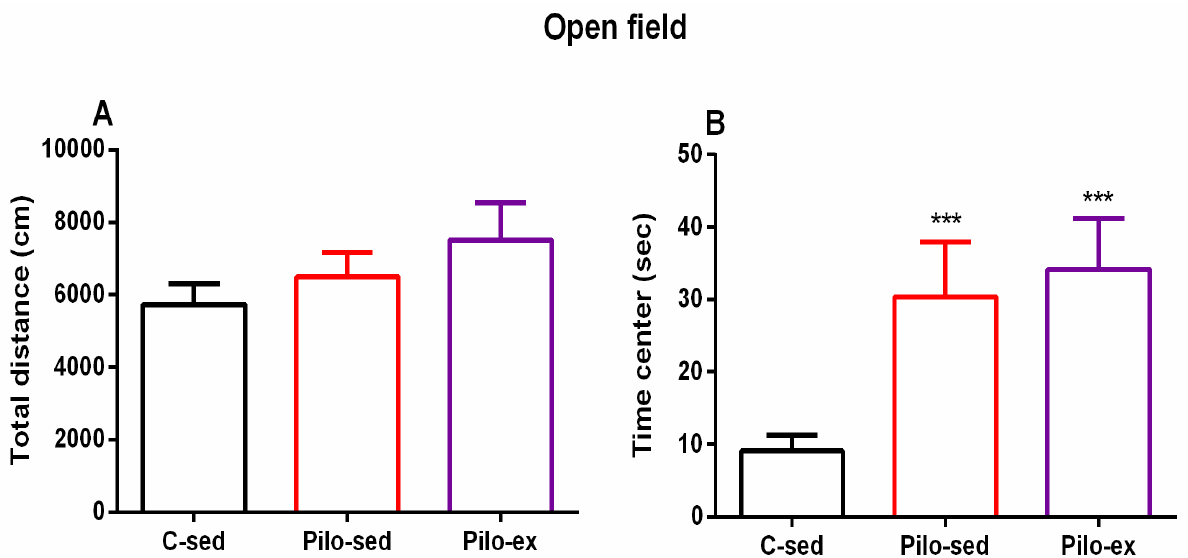
Figure 5. Effect of endurance training, applied before and after SE, on ( A ) total distance and ( B ) on the time (s) in the center in the open field test. *** p < 0.001 in comparison with the C-sed group. 2.3.5. Endurance Training, Applied before and after SE, Alleviated the Anxiety-Like Behavior in the Elevated Plus Maze Test (EPM) in the Pilo-Induced Post-SE Rat Model of TLE ANOVA revealed a significant main effect of exercise [F(2, 23) = 4.031, p = 0.033] on the number of entries in the open arms of EPM. There was a tendency for a higher number of entries in the open arms of EPM of the Pilo-ex group compared to the C-sed and the Pilo-sed animals ( p = 0.057 and p = 0.059, respectively) (Figure 6A). Analysis of variance demonstrated a significant main effect of exercise [F(2, 23) = 17.311, p < 0.01] on time spent in the open arms of the EPM. Both groups treated with Pilo had decreased levels of anxiety, and spent a longer time in the aversive area in comparison with the C-sed animals ( p = 0.017 and p = 0.001, respectively) (Figure 6B). Moreover, en- durance training enhanced this impulsive-like behavior ( p = 0.024 compared to the Pilo- sed group) (Figure 6B).